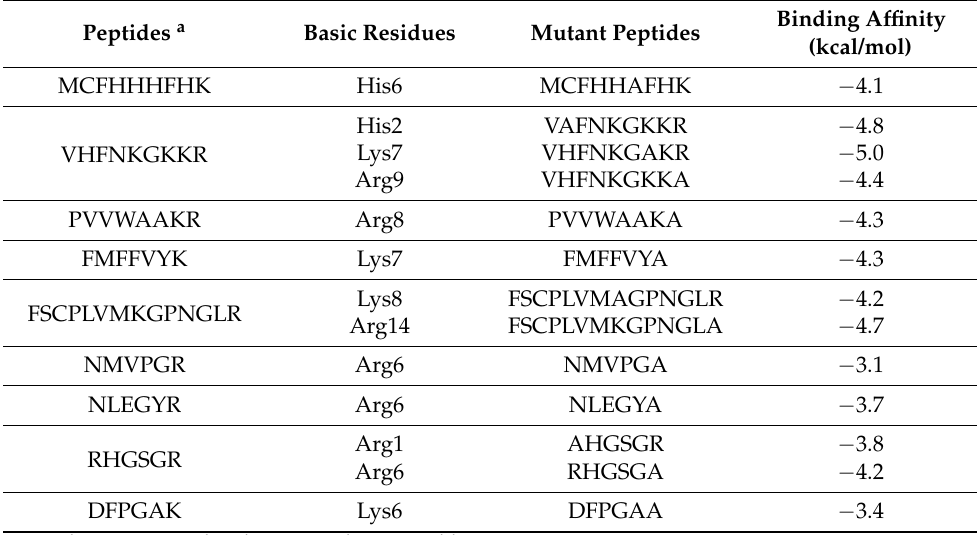
Table 4. Binding affinities of corn silk peptides toward ABTS • + upon alanine substitution of the basic residues that were involved in ABTS • + -peptide